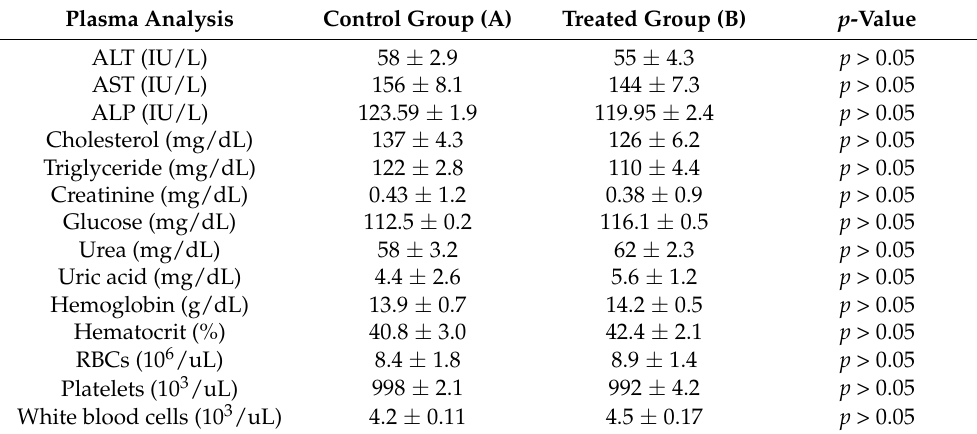
Table 4. Biochemical plasma analysis of control and hydrogel-treated group. Plasma Analysis